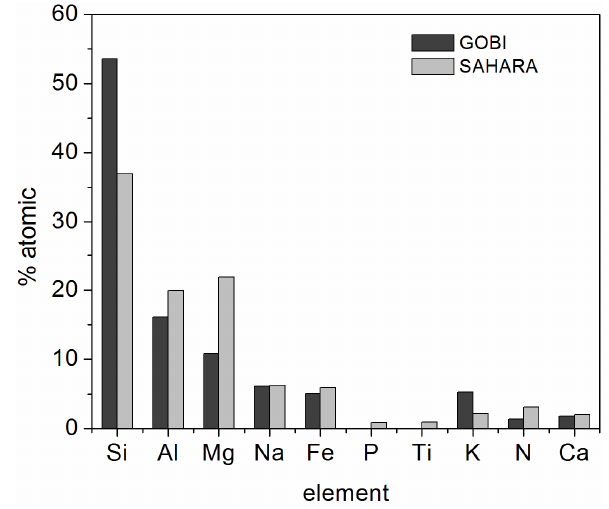
Fig. 1. Composition of Saharan and Gobi dust aerosol, as deter- mined by high resolution Figure 1. Composition of Saharan and Gobi dust aerosol, as determined by high resolution 3 XPS. 4